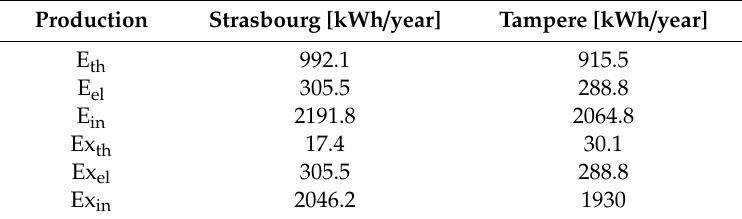
Table 4. Simulation results of the energy and exergy